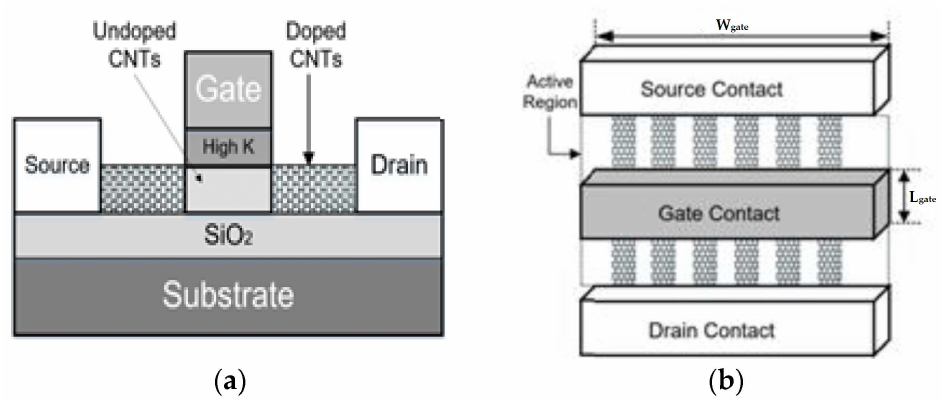
Figure 2. ( a ) Side view of a CNFET, ( b ) Top view of CNFET.